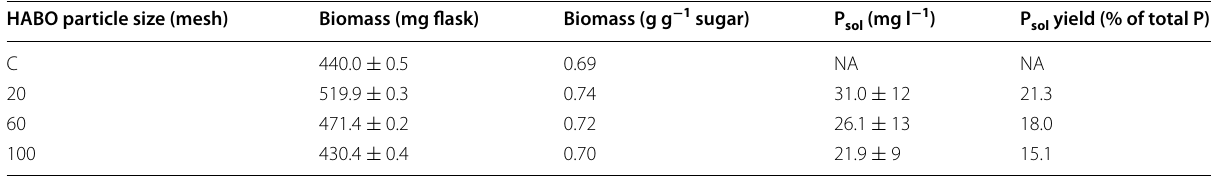
Table 1 Solubilization of different particle size of HABO (1.0 g l − 1 ) by freely suspended P. indica in a single 120-h batch fermentation